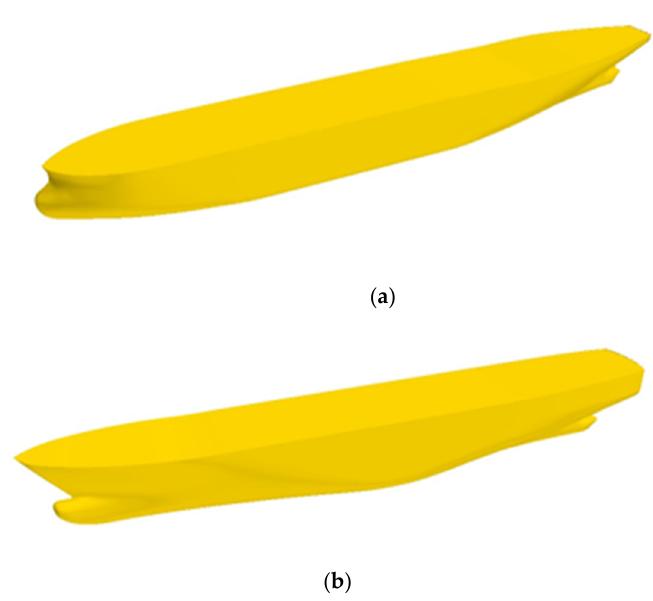
Figure 6. Size setting of 3D numerical wave tank.